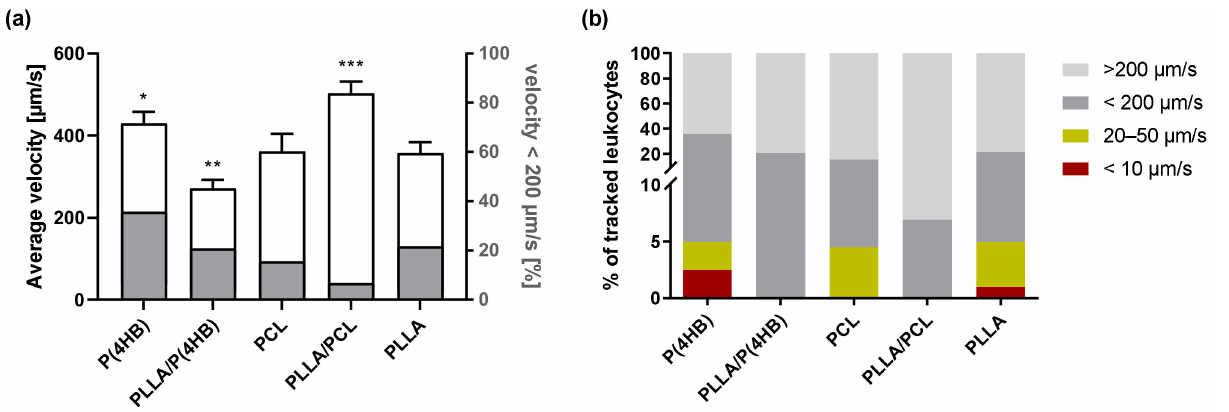
Figure 3. Material-dependent leukocyte movement. Human peripheral blood mononuclear cells (PBMCs) were isolated from an in-line filter system for leukocyte filtration, stained with Calcein Red-Orange, AM and exposed to laminar flow with a shear rate of 50 s − 1 for 5 min. ( a ) Average velocity of leukocytes was tracked using NIS-Elements AR Imaging Software. Bars show mean average velocity ± SD of 5 independent experiments compared to the PLLA surface with * p < 0.05, ** p < 0.01 and *** p < 0.001. ( b ) All tracked leukocytes were grouped regarding their velocity to vizualize velocity distribution on the different